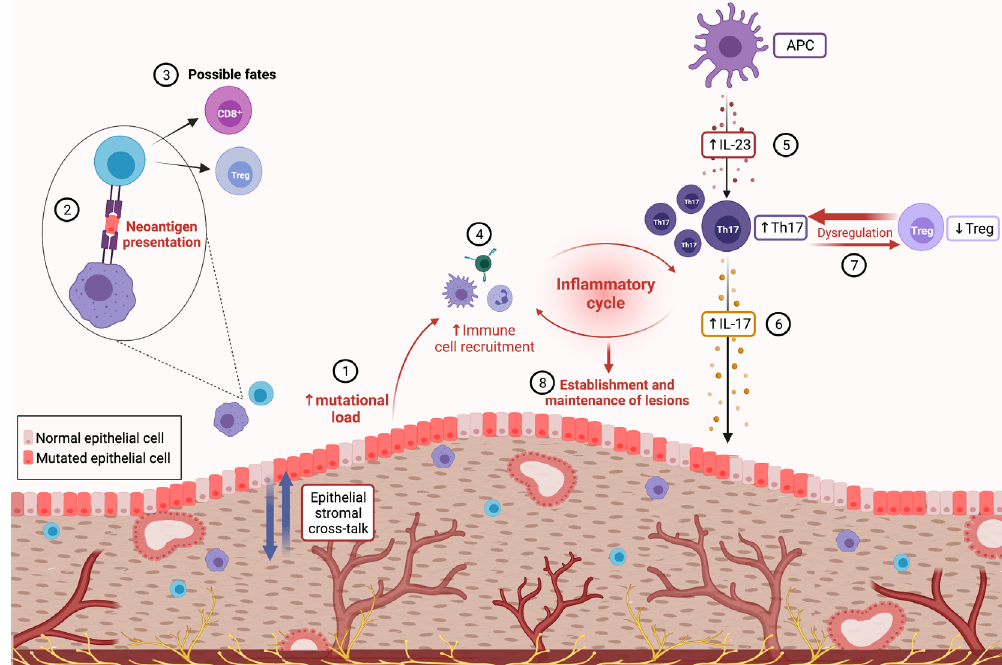
Figure 2. Lesion immune microenvironment and inflammatory cycle. (1) Inherent mutational predispositions differ across epithelial and stromal cells. Epi-genetic stromal cell alterations promote an environment that stimulates further replication and mutational acquisition within epithelial cells. (2) This increased presence of somatic mutations allows for the formation of neoantigens which are detected by antigen-presenting cells (APCs) and presented to adaptive immune cells. (3) The lymphocyte fate from these interactions is yet to be determined, forming a novel target of the investigation to define immune phenotype and activation status of T cells in response to lesion-specific neoantigens. (4) Phenotypic fate is not yet determined, but higher immune cell infiltration has been seen in lesions with increased somatic mutations. Elevated immune cell infiltration is a facet of another potentially dysregulated pathway within the lesion microenvironment. (5) IL-23, which is increased in EMS, is mainly secreted by APCs. (6) This cytokine is crucial for the expansion and stabilization of “pathogenic” Th17 cells resulting in high levels of IL-17, which has potent pro-inflammatory and pro-angiogenic actions in EMS. (7) IL-23 may also then promote the dysregulated ratio of Th17 and Treg cells seen in EMS derailing immune homeostasis. (8) As IL-17 receptor A (IL-17RA) is expressed on immune cells including T cells, IL-17 may promote Th17 cells to induce inflammation, recruit neutrophils, and further produce pro-inflammatory